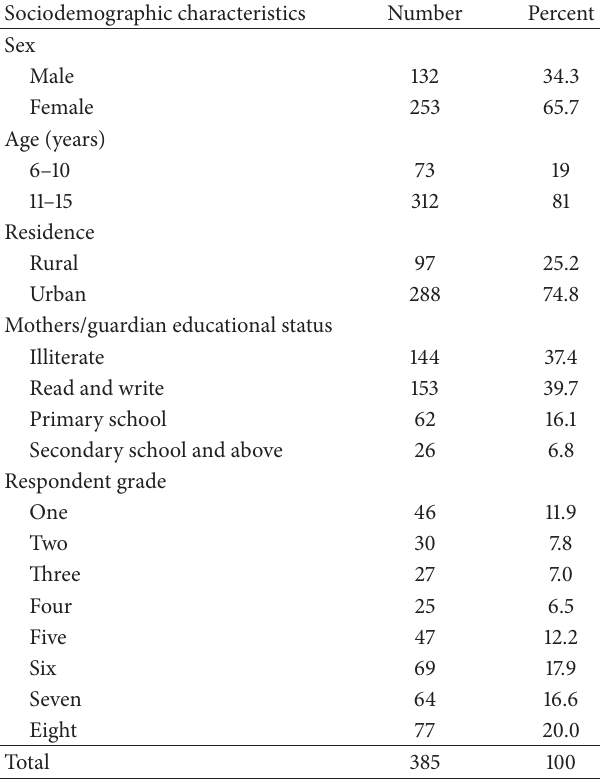
Table 1: Sociodemographic characteristics of school children in Sanja General Elementary School, Sanja, northwest Ethiopia, 2013.